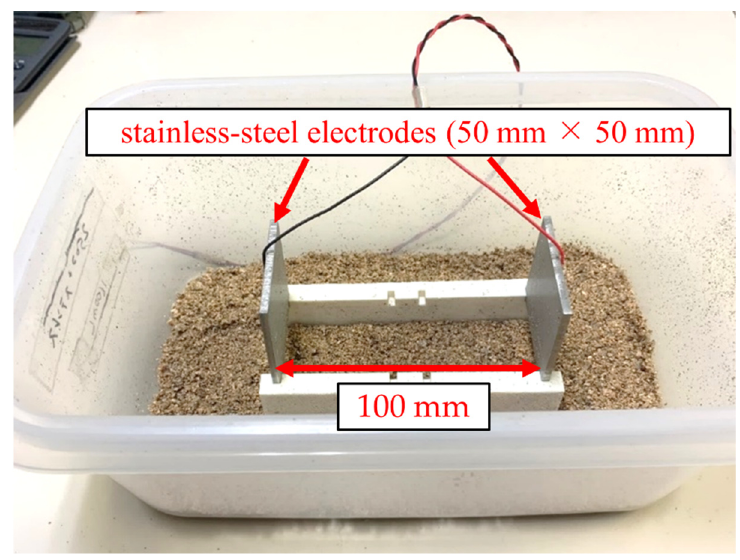
Figure 16. The experimental setup for the water content measurements.